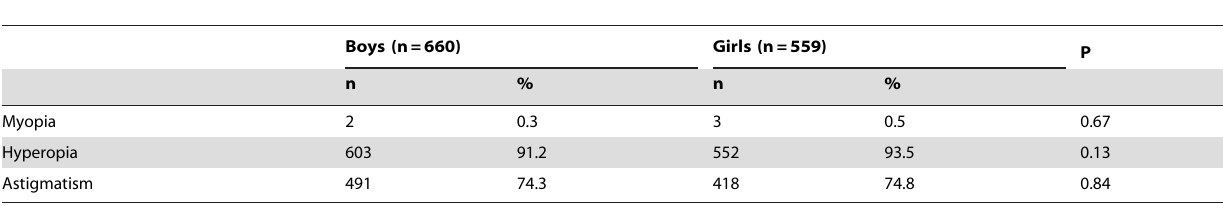
Table 1. Prevalence of refractive errors by